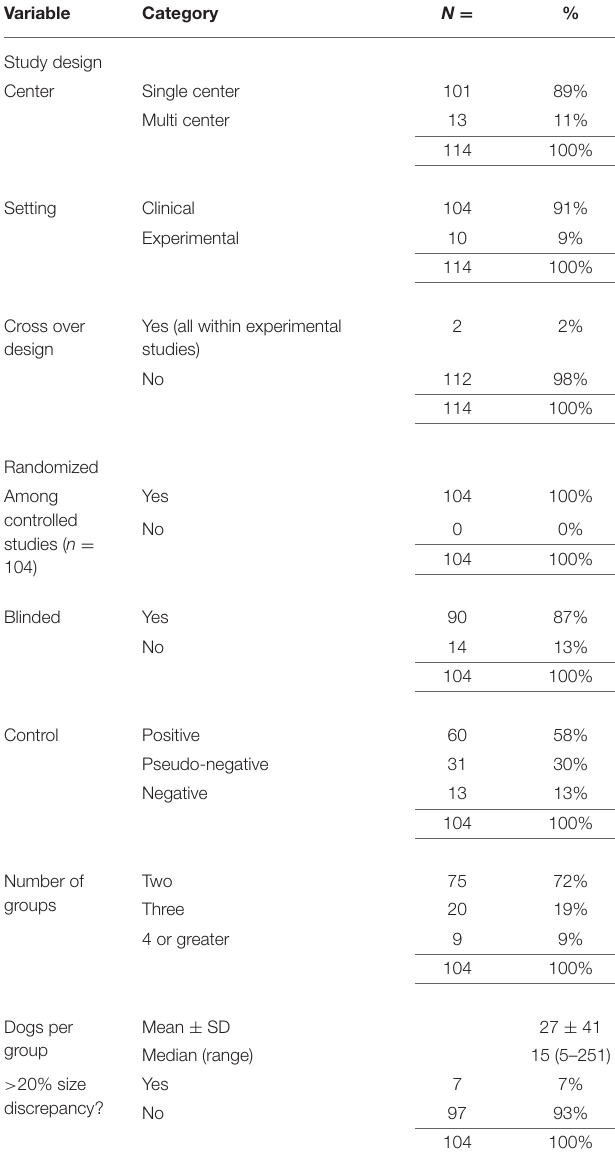
TABLE 4 | Variables describing features of study design in the